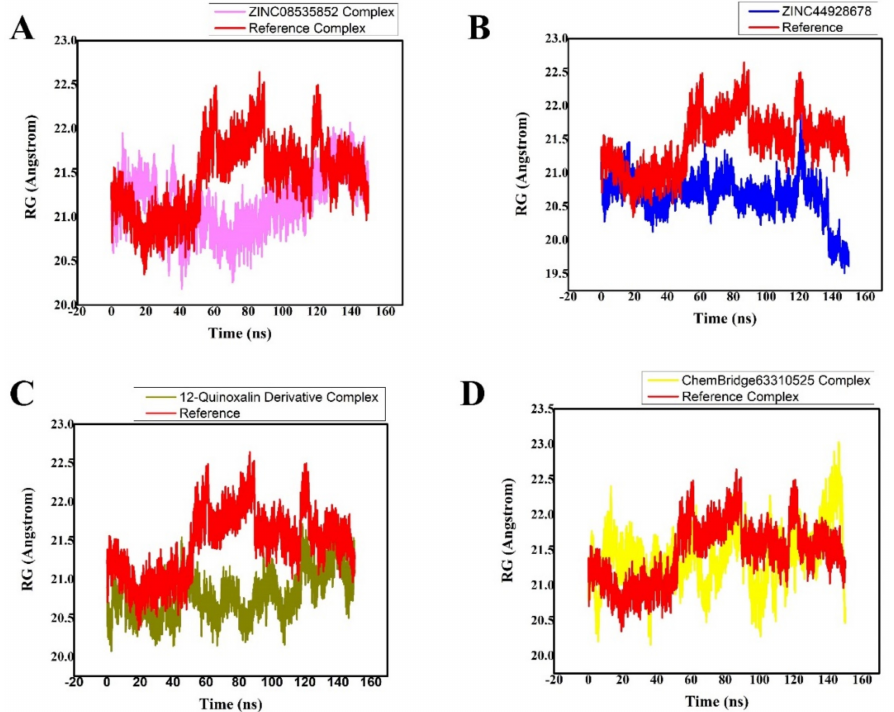
Figure 8. ( A – D ) The radii of gyration of the identified lead hits/M pro (purple, blue, olive green, and yellow, respectively) and ref-ligand (N3)/M pro (red color) complexes were